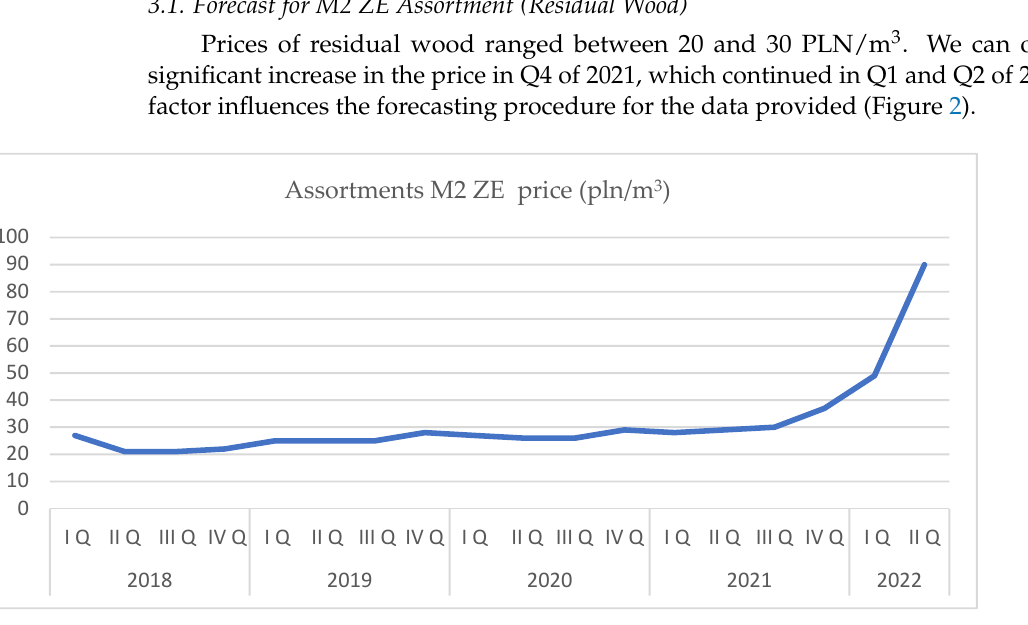
Figure 2. Prices for the M2 ZE assortment at quarterly intervals in years 2018–2022. Source: Own elaboration based on data obtained from the State Forests IT System (SILP). The ARIMA (0, 2, 0) model was used during the data analysis to assign relevant p, d, q parameters to the ARIMA method (Figure 3).